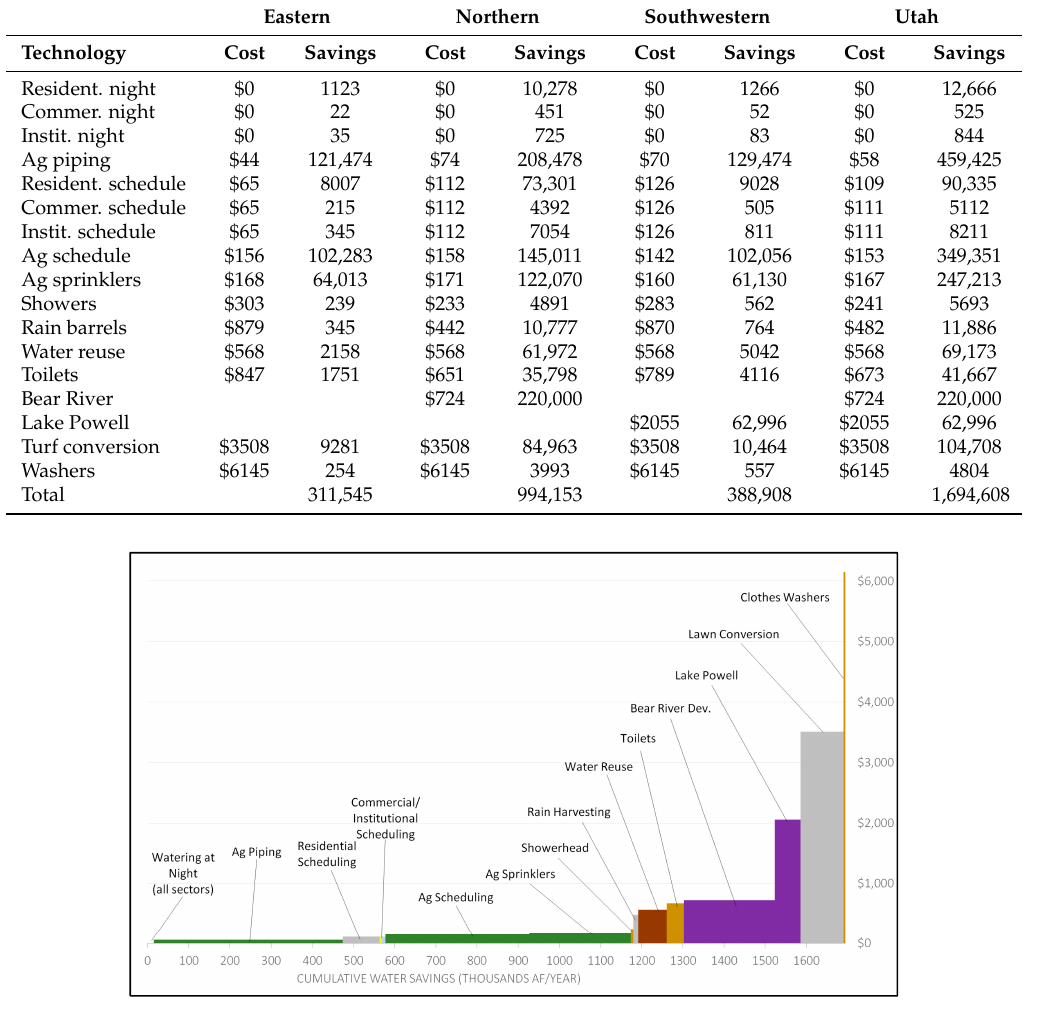
Table 5. Regional and statewide savings (in AF) and cost estimates.